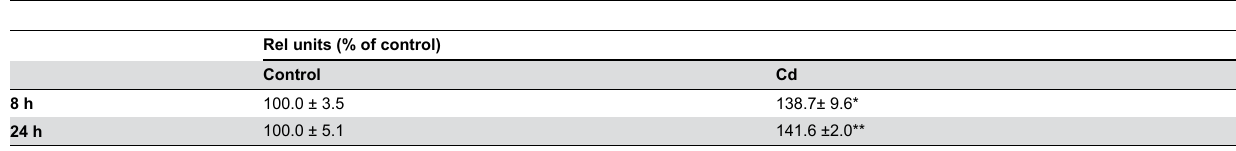
Table 4. Cadmium modifies ERα mRNA expression in anterior pituitary cells.